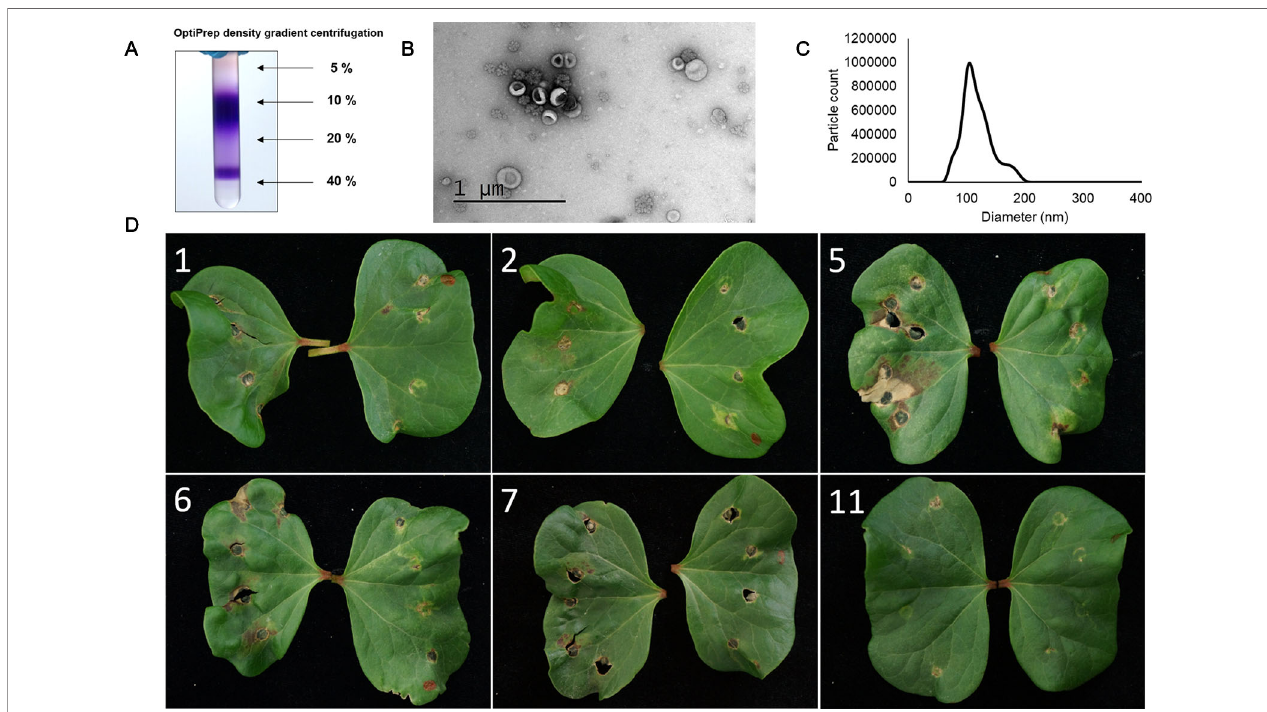
FIGURE 4 | The optiprep fractions containing both EVs and the purple pigment are responsible for the hypersensitive response induced by the crude EV fraction in plants. (A) Optiprep gradient centrifugation of the crude EV fraction revealed that the purple pigment concentrates in two regions, one centered at 10% and a second close to 40% iodixanol. The purple pigment was concentrated in fractions 5 – 7. (B) Representative TEM of fractions 5 – 7. Particles with characteristic cup-like morphology of EVs were detected in these fractions as well as some rosette-shaped particles. (C) Representative NTA of fractions 5 – 7. The mode particle diameter was 104.5 nm; no particles were detected below 46.5 nm or above 226.5 nm. (D) Application of select fractions (numbered in white) to the cotyledons of a cotton plant. Fractions (left cotyledon) were all paired with a PBS control (right cotyledon). Fraction 5 induced the strongest response with fractions 6 and 7 inducing a lesser response. Fractions 1, 2, and 11 did not induce a response beyond that observed for the PBS control. The brown spots and holes on the control cotyledons are due to wounding of the leaf during in fi